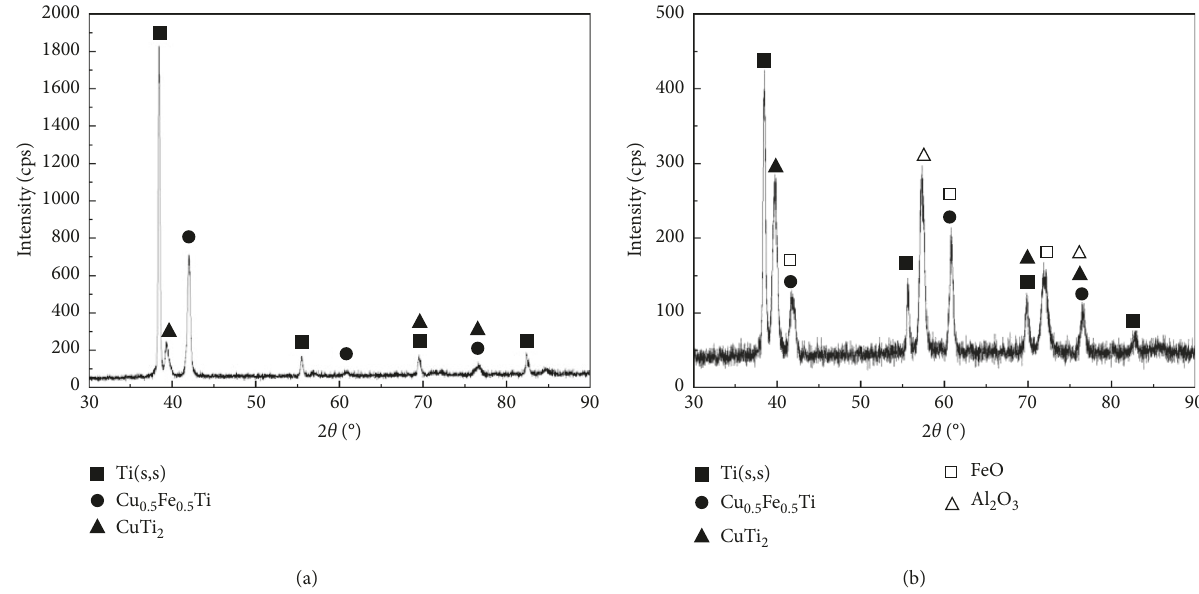
Figure 9: XRD patterns of fracture surface of welded joints: (a) EBW-1; (b)